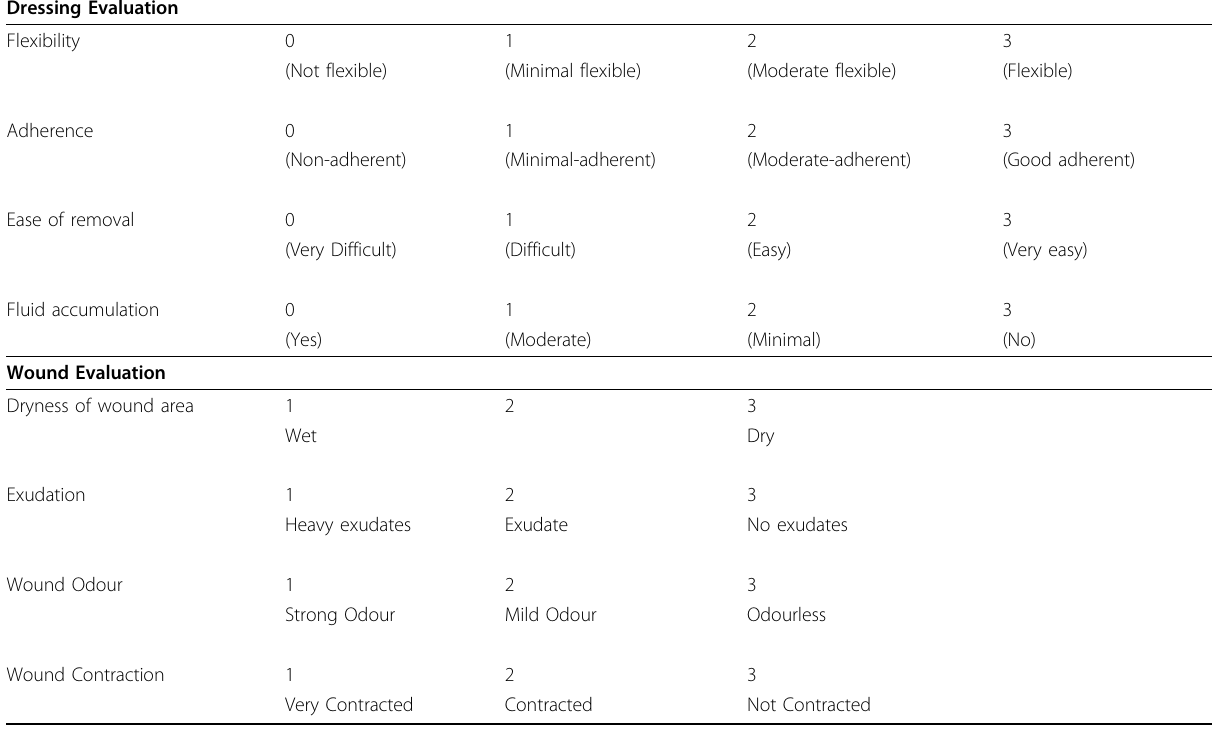
Table 1 Dressing and wound evaluation system Dressing Evaluation